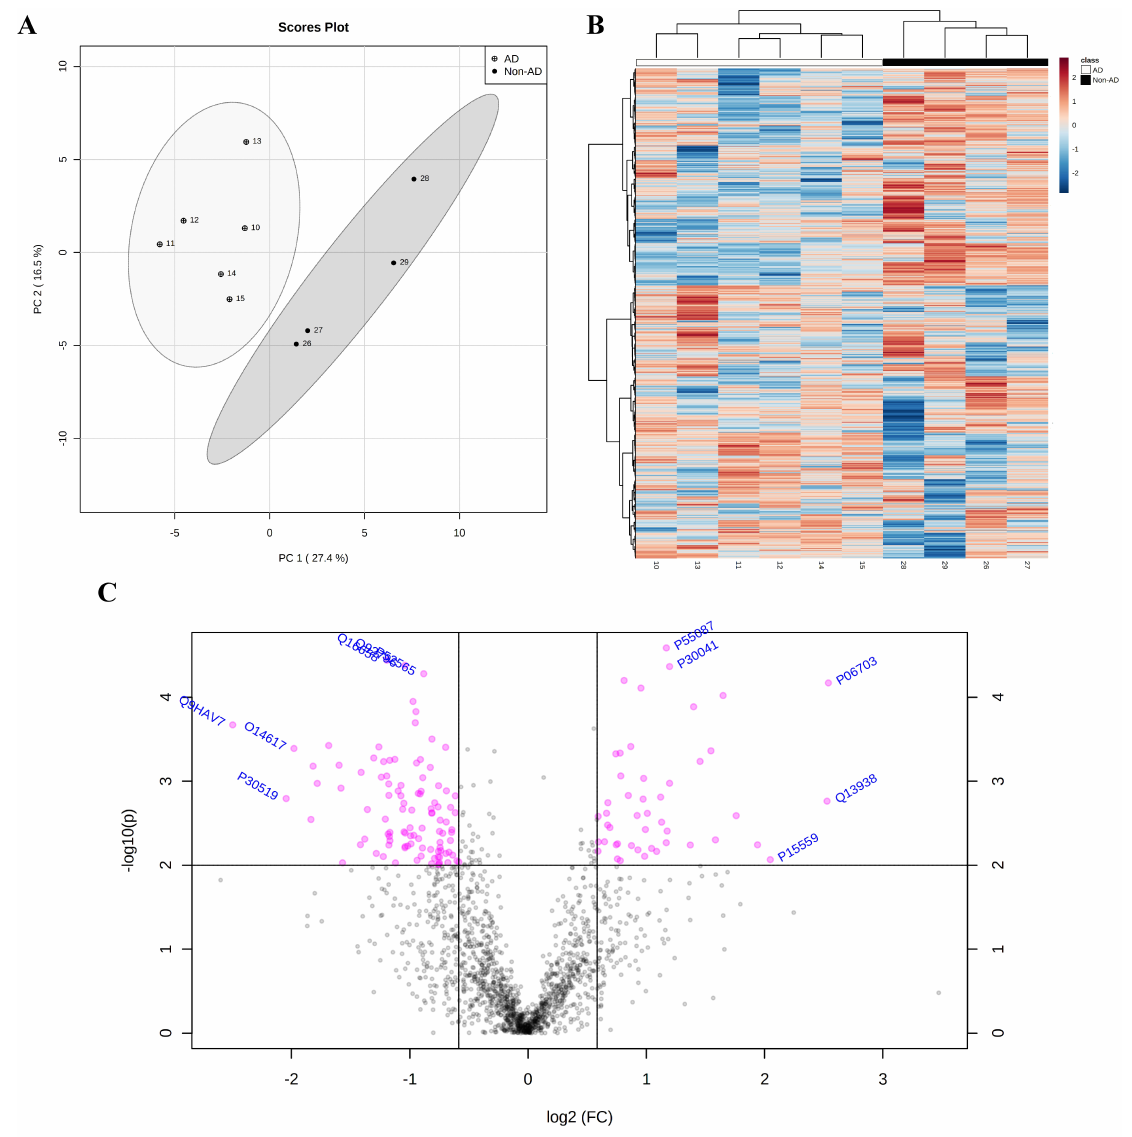
Figure 5. Prominent downregulated proteins in AD samples. Principal component analysis (PCA) revealed two-well defined groups of AD and non-AD samples ( A ). The cluster analysis data visualized by heatmap reveal the differential expression of 1635 proteins between groups ( B ). The volcano plot shows 47 up- and 102 downregulated proteins among a total of 1635 analyzed proteins ( C ) (FC > 1.5, p value < 0.01). Statistical analysis was performed with MetaboAnalyst